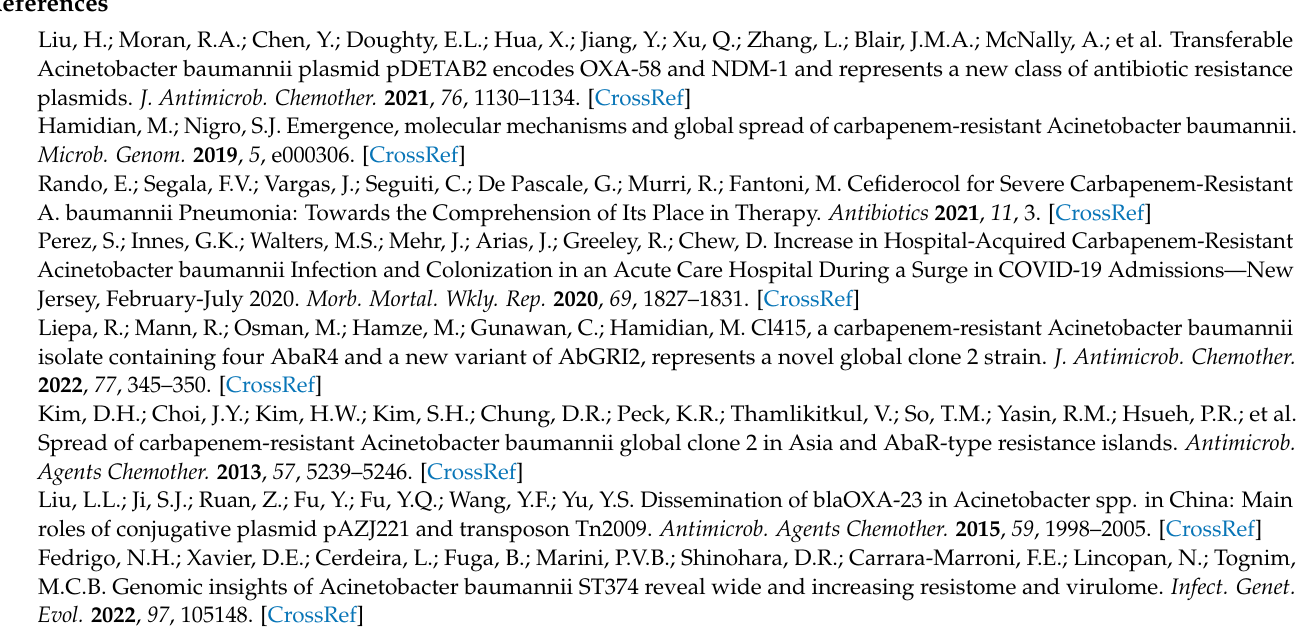
Table S1. Site-specific recombinases XerC/XerD (C/D) and XerD/XerC (D/C) in the chromosome of A. baumannii ZHOU